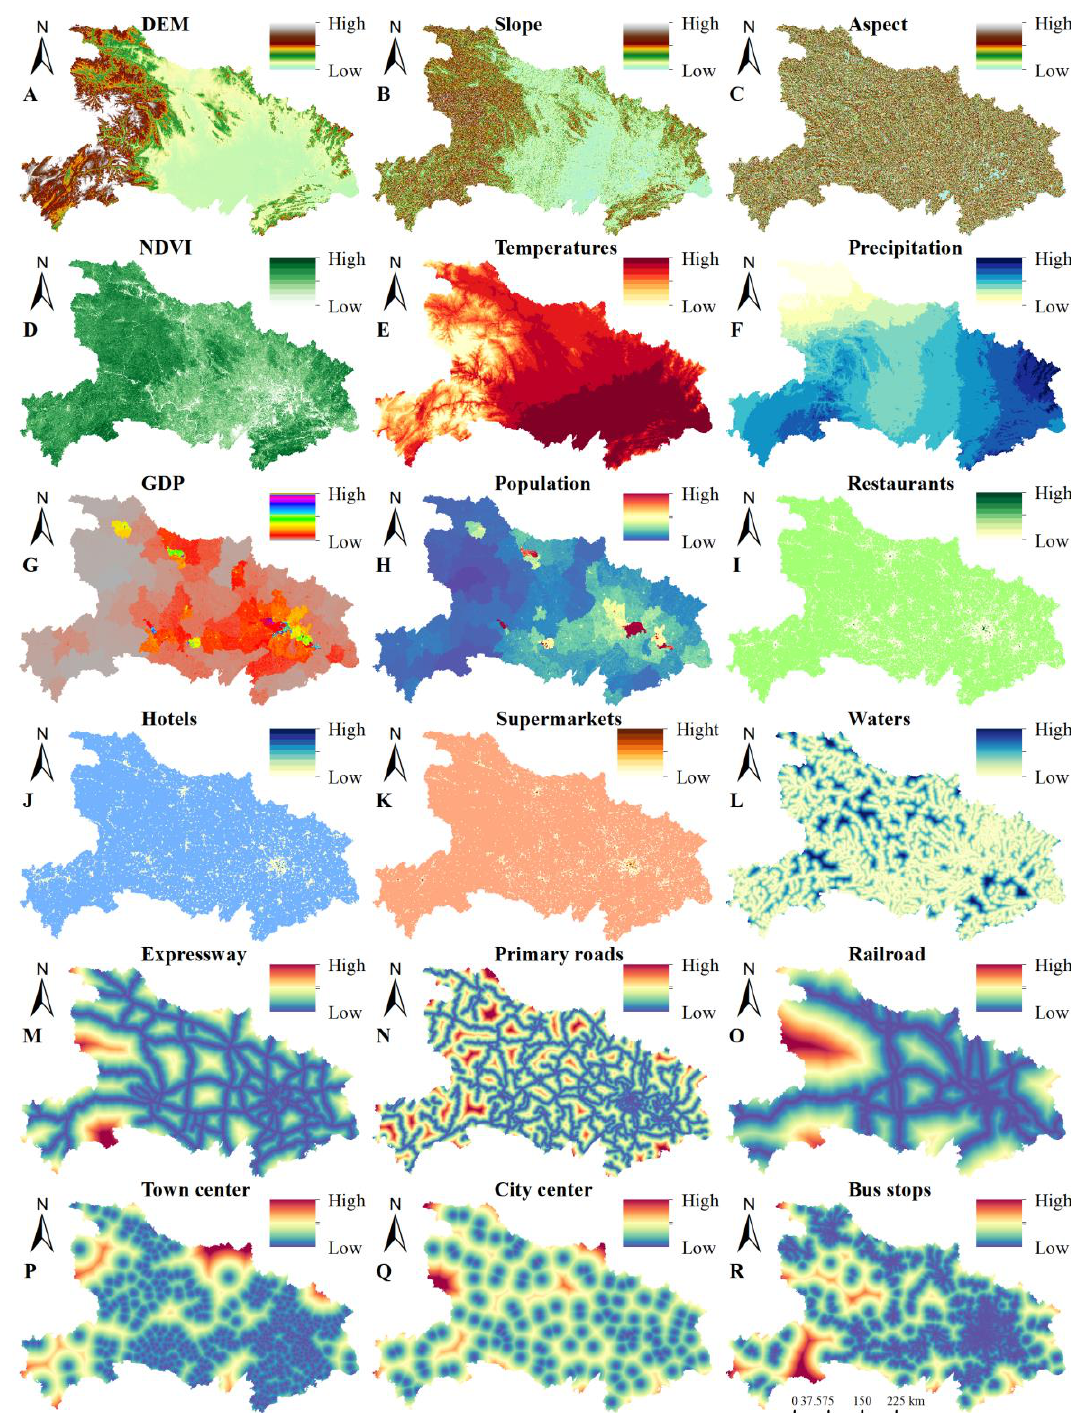
Figure 3. Drivers of land-use change. ( A ) DEM, ( B ) slope, ( C ) aspect, ( D ) NDVI, ( E ) temperatures, ( F ) precipitation, ( G ) GDP, ( H ) population, ( I ) restaurants, ( J ) hotels, ( K ) supermarkets, ( L ) waters, ( M ) expressways, ( N ) primary roads, ( O ) railroads, ( P ) town centers, ( Q ) city centers, ( R ) bus stops.